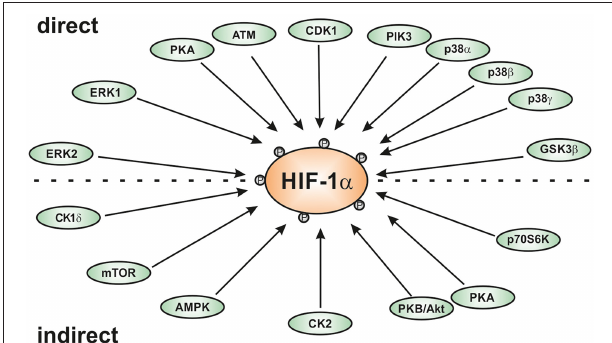
FIGURE 1 | Scheme of kinases involved in regulating HIF-1 α either direcly or indirectly. AMPK, AMP-activated kinase; ATM, ataxia and teleangiectasia mutated; CK1, casein kinase1; CDK1, cyclin-dependent kinase-1; ERK; extracellular regulated kinase; GSK3 β , glycogen synthase kinase-3 β ; PKA, protein kinase A; PKB/Akt, protein kinase B or Akt kinase; p38, p38 mitogen activated protein kinase; Plk3, polo-like